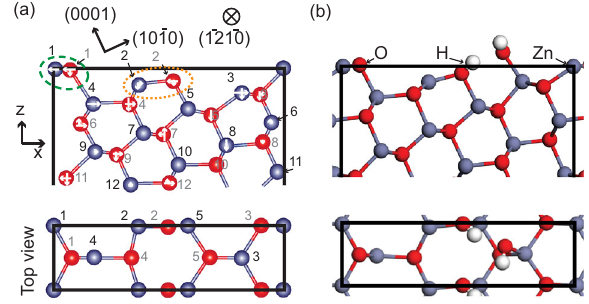
-- Fig. 3 Structural models of the ZnO(10 14) unit cell. a The bulk truncated surface model. White arrows indicate the fi tted displacements. Atomic colorcode: H (white), O (red), Zn (blue). Orange dotted oval: Zn-O pair removed for Model B, Green dashed oval: Zn-O pair removed for Model C. Numbers correspond to the labels in Table SI. b DFT optimized structure based on Model A, including one dissociated H 2 O molecule per unit